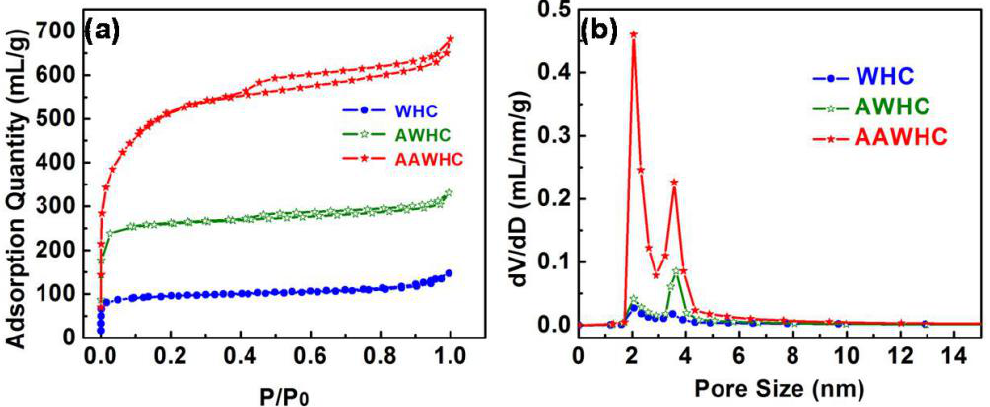
Figure 3. ( a ) N 2 adsorption/desorption isotherms of the samples. ( b ) The pore size distribution of the samples. Table 1. Pore structure properties of samples (SSA: Specific Surface Area).